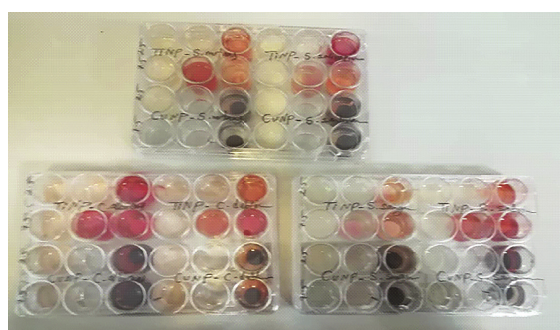
Figure 1: 24-cell plates containing acrylic